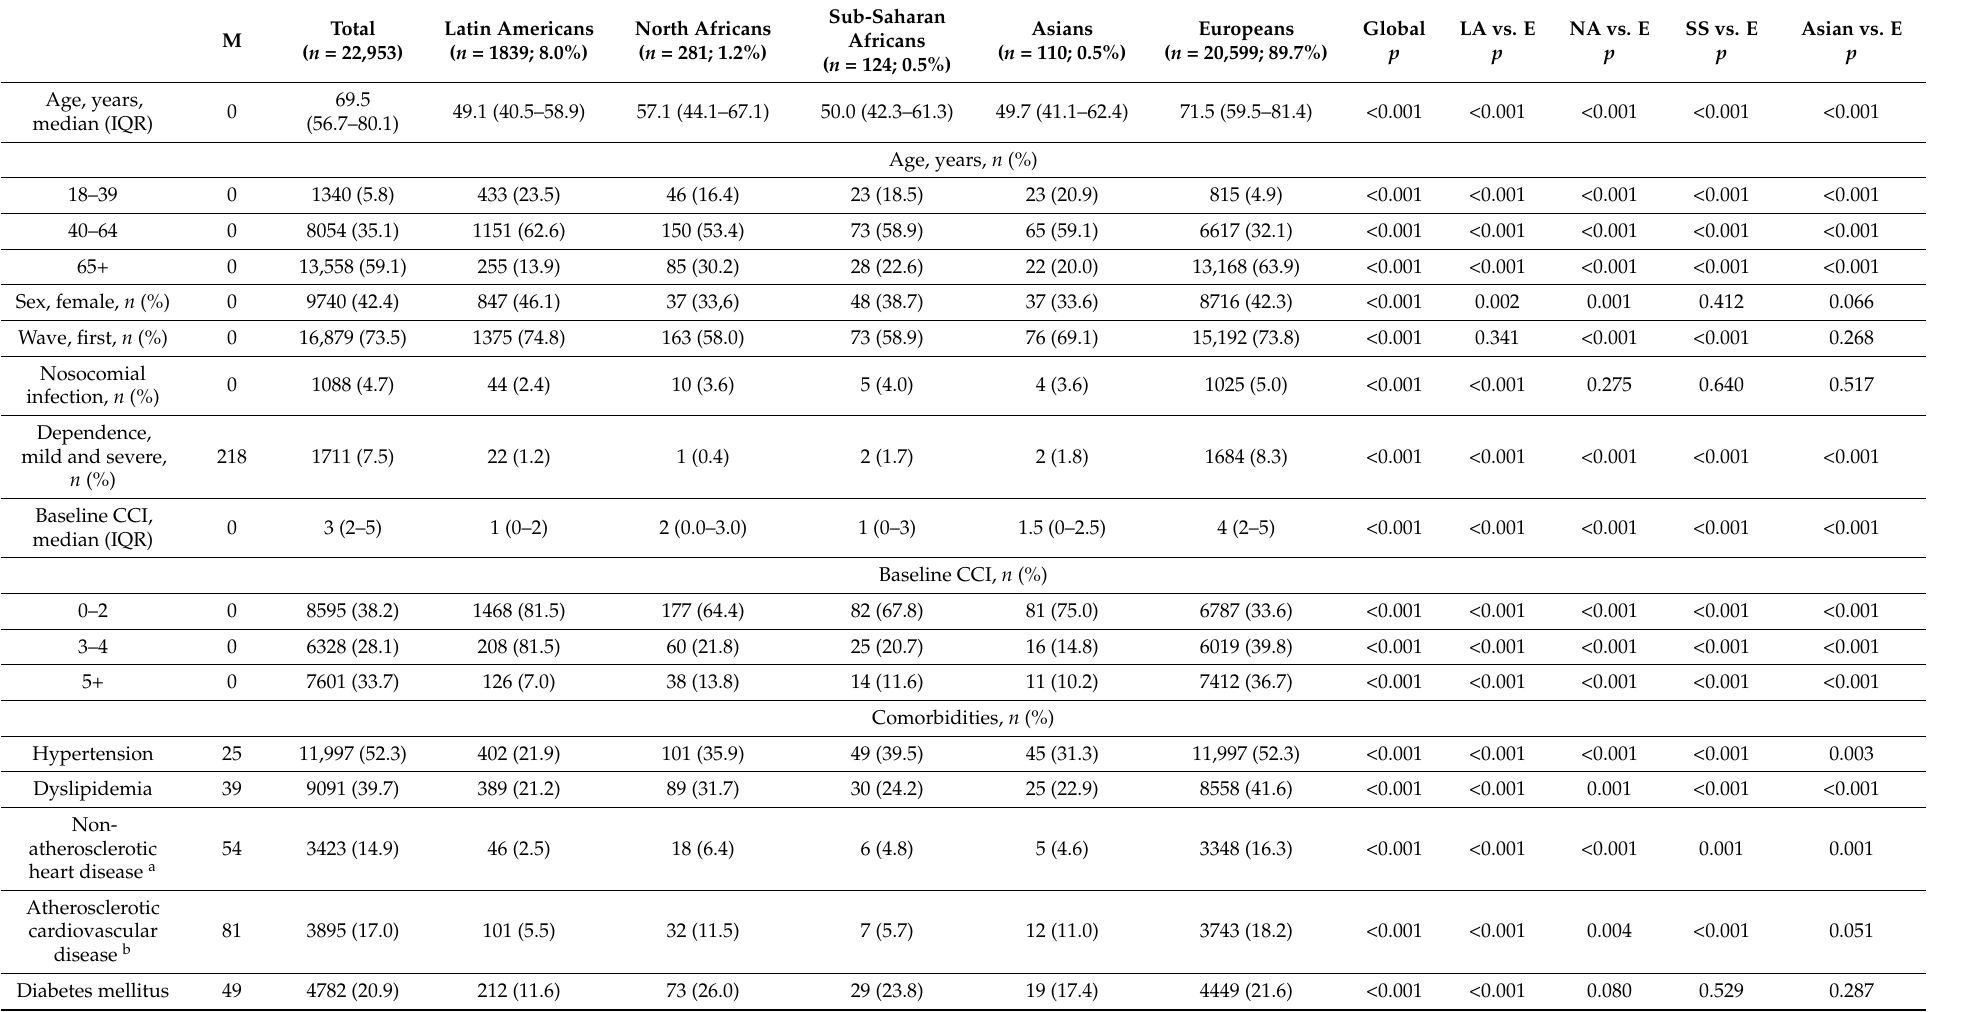
Table 1. Demographic and clinical characteristics of patients with confirmed COVID-19 by ethnic